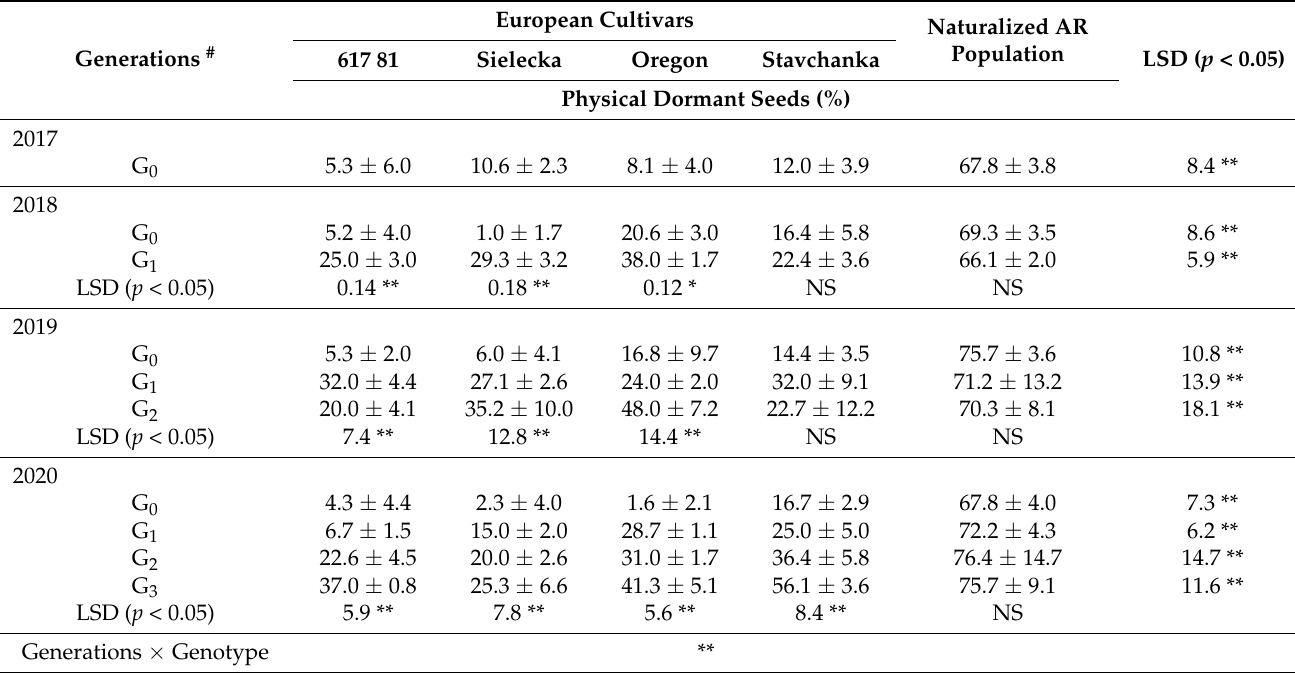
Table 2. Percentage of dormant seeds’ PY (mean and standard deviation) of hairy vetch (HV) genotypes for each year and generation.